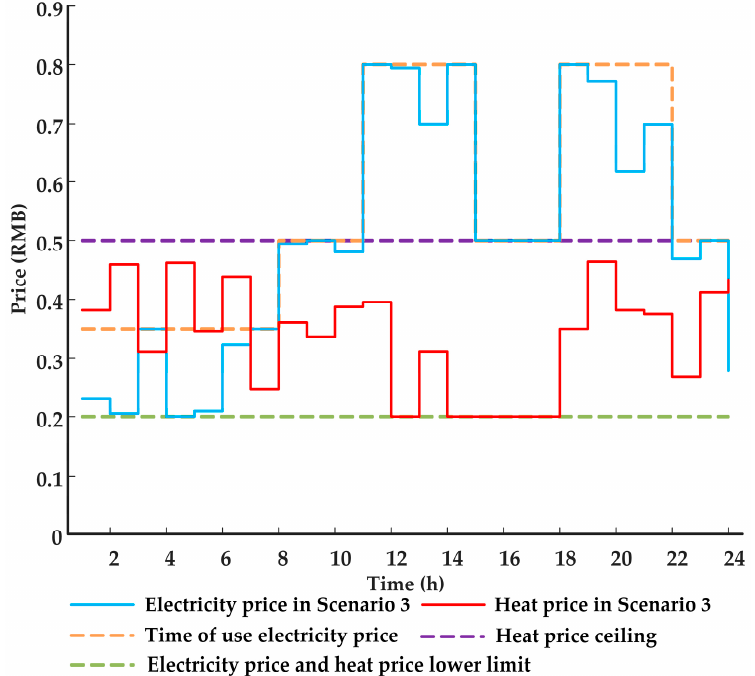
Figure 4. The price of electricity and heat that the operator trades with users.